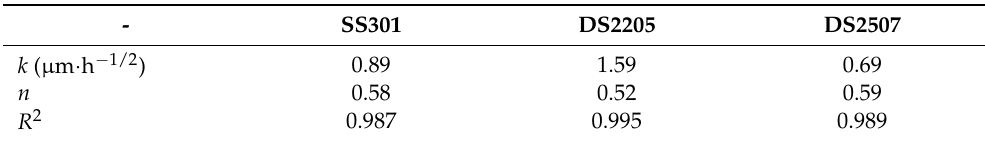
Table 2. Experimental parameters of Equation (2) after fitting the thickness loss of metal at the exposure times and R -squared